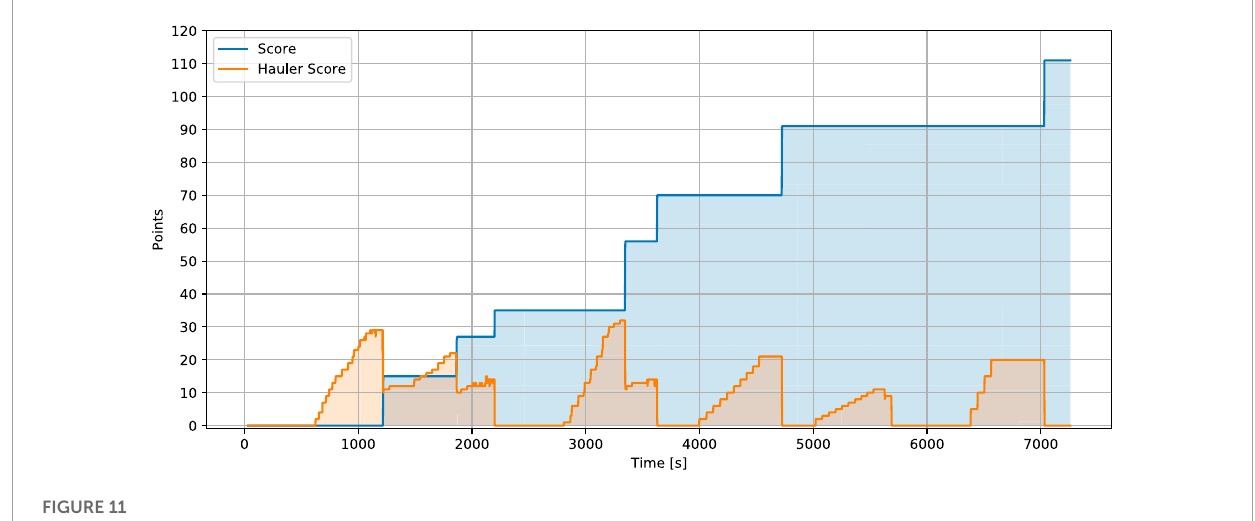
FIGURE 11 Score achieved during a two-hours mission with six